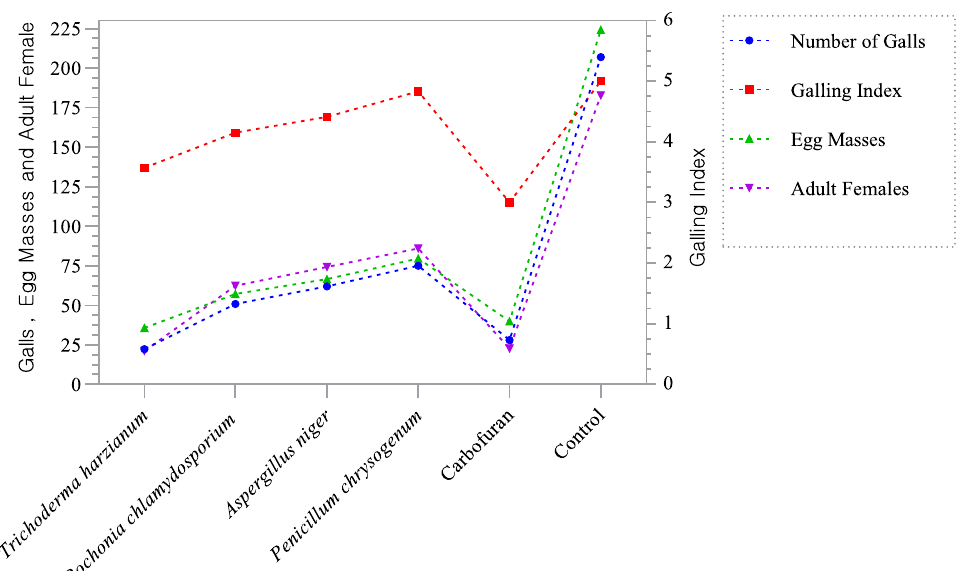
Fig. 3 Effects on the Meloidogyne incognita parameters in the eggplant root system inoculated with various fungal Biocontrol agents at the in-planta